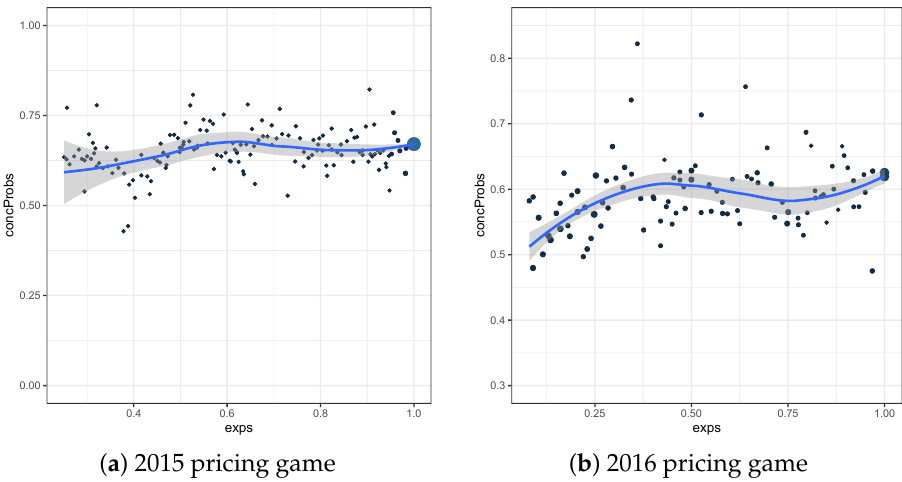
≈ ( λ ,0.05 ) based on the dataset of the 2015 and 2016 Figure 8. Weighted-mean-plot for ˆC ep , kM ,0,1 + pricing game. It is obtained by using the number of clusters that resulted in the highest